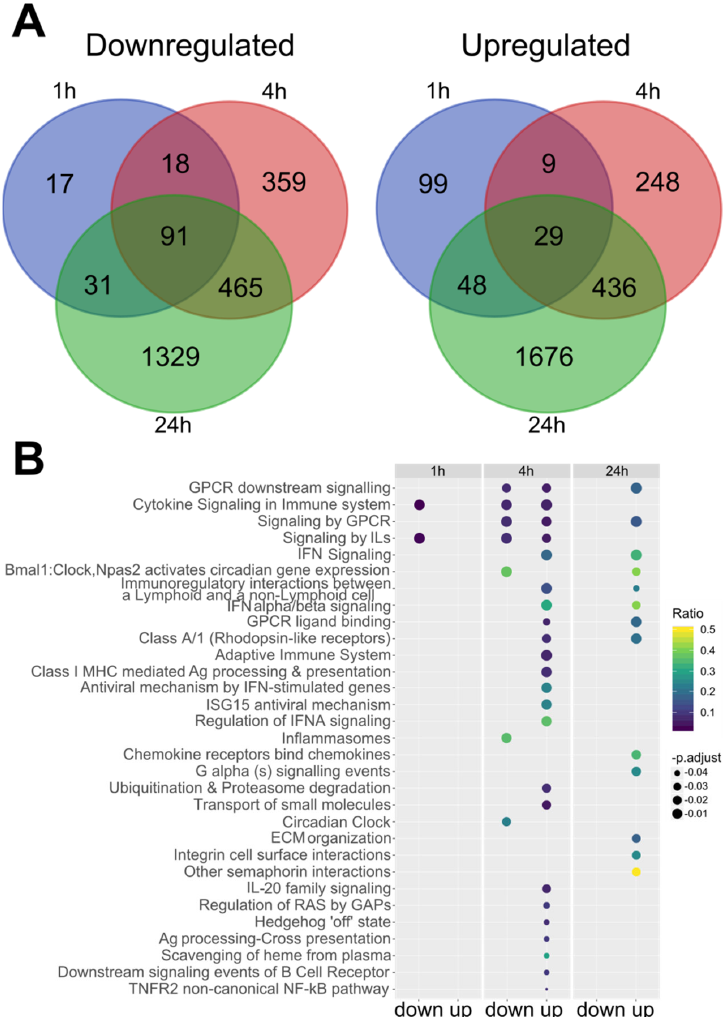
Figure 2. SCH772984 changes RAW 264.7 cells transcriptomes by altering gene expression pathways related to immune system pathways upon LPS challenge. (A) Venn diagram illustrating the number of up and downregulated DEGs (adj. p . value < 0.05) and Reactome pathways (B) altered upon SCH772984 treatment during the LPS challenge time points. IL—interleukin; IFN—interferon; Ag—antigen; ECM—extracellular matrix